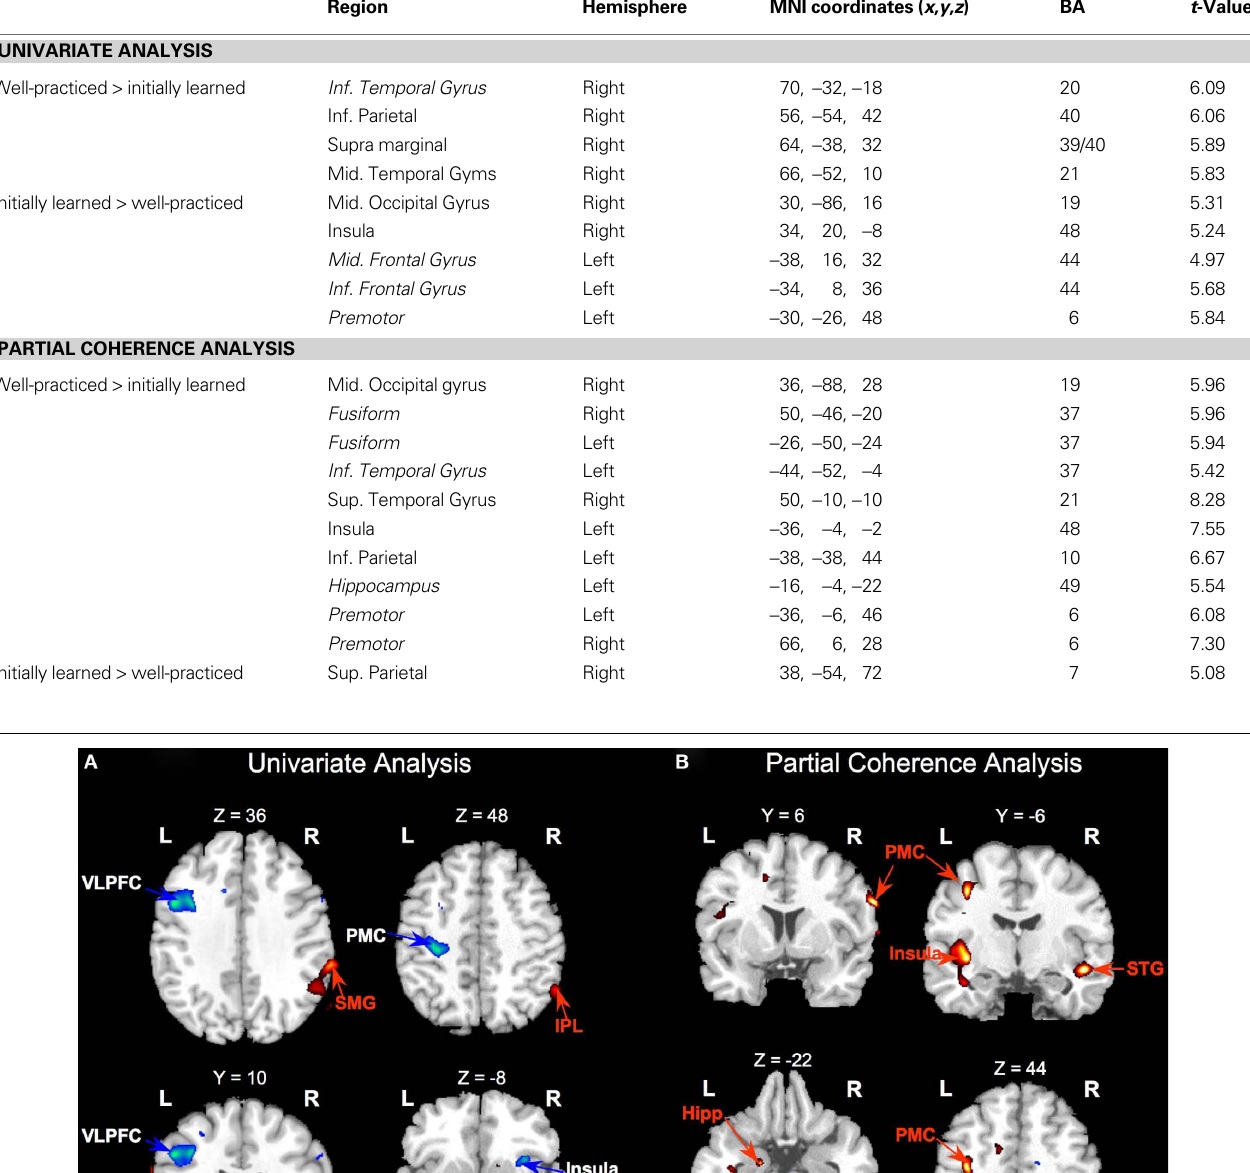
Table 1 | Regions that show activity and partial coherence differences between initially learned and well-practiced tasks (corrected at p < 0.001). Hypothesized regions are